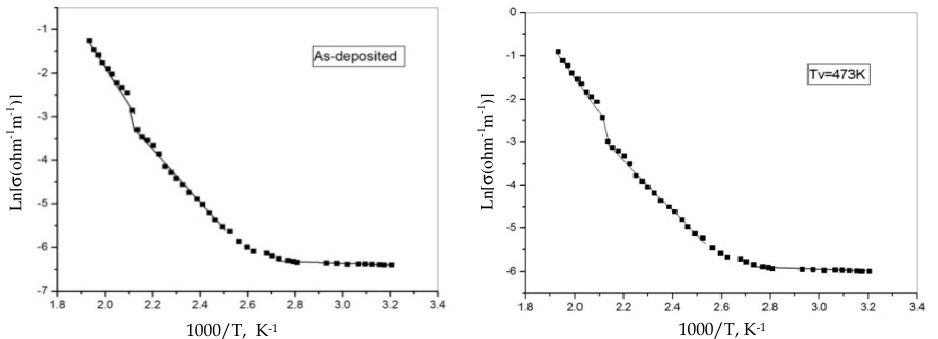
Figure 6(b). Plot of ln σ vs . 1000/T for the film annealed at 473